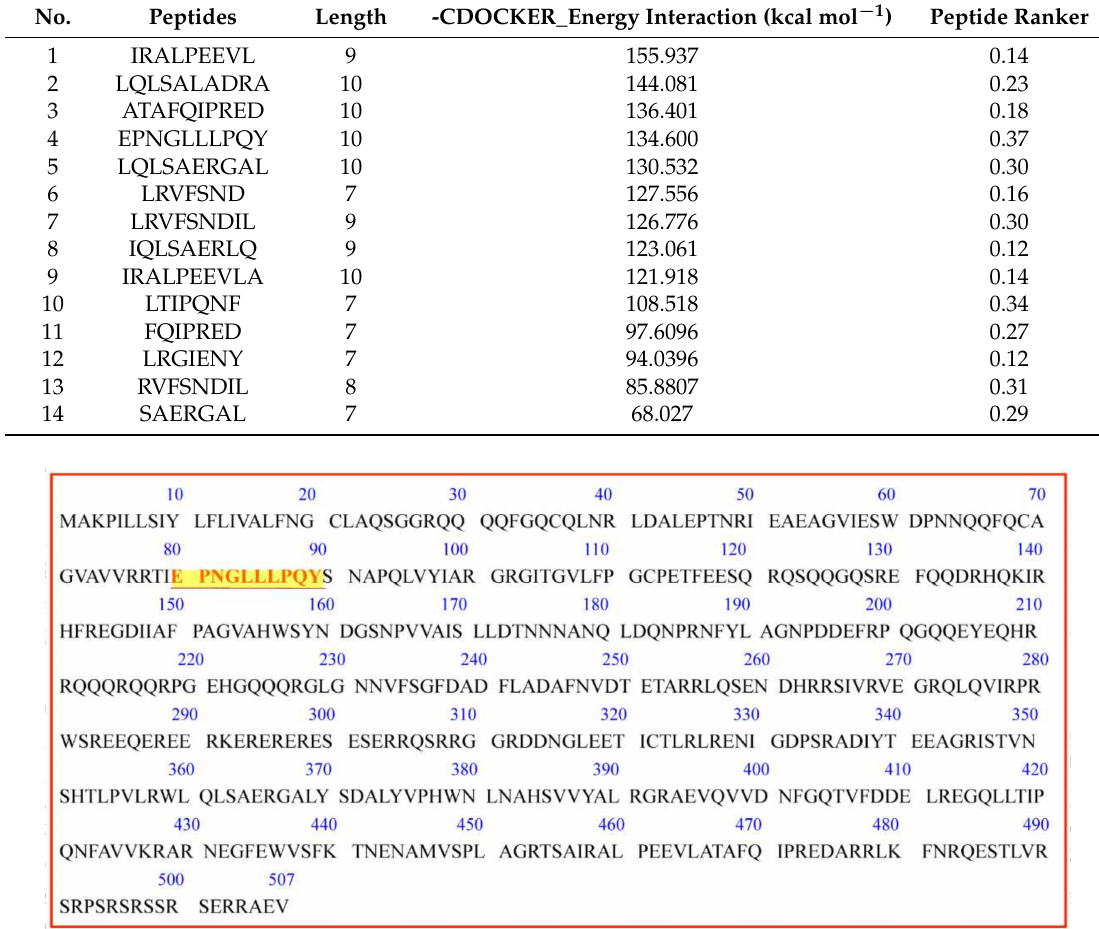
Table 2. Peptides analysis by Peptide Ranker and molecular docking.